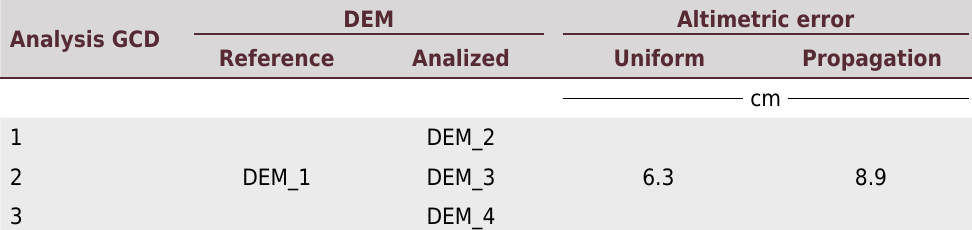
Table 4. Altimetric errors in the geomorphic change detection analysis Analysis GCD